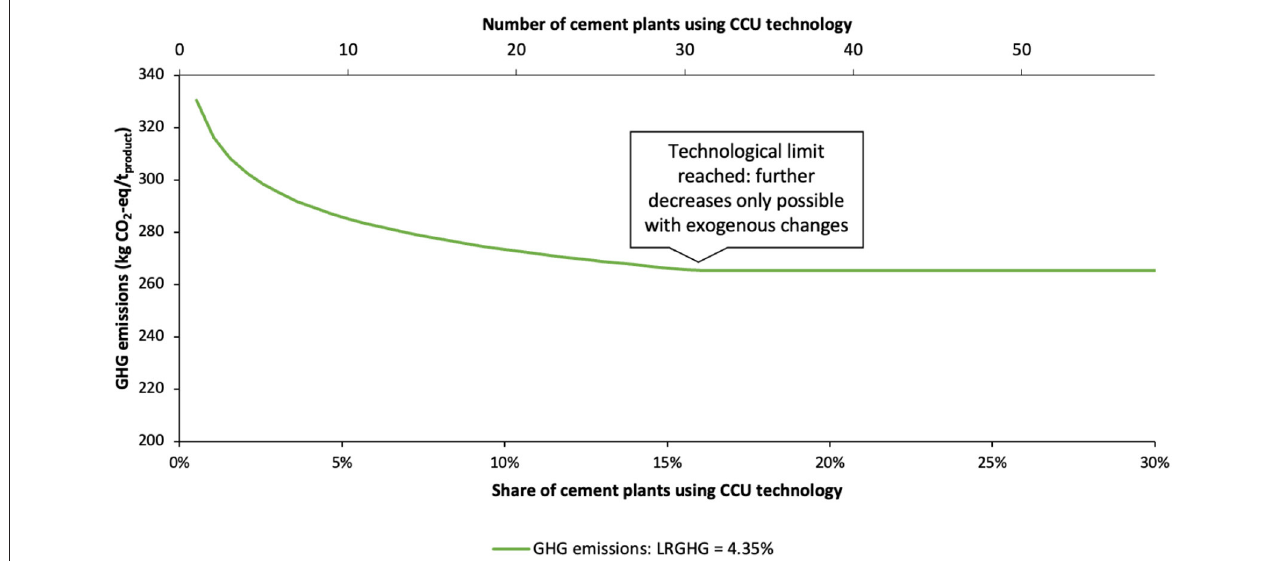
FIGURE 3 | Technology learning curve for mineralization system emissions. Technological limit occurs when additive recycling and process yield are 100%; further improvements to environmental performance would have to arise from improvements in the environmental performance of exogenous factors, such as feedstocks